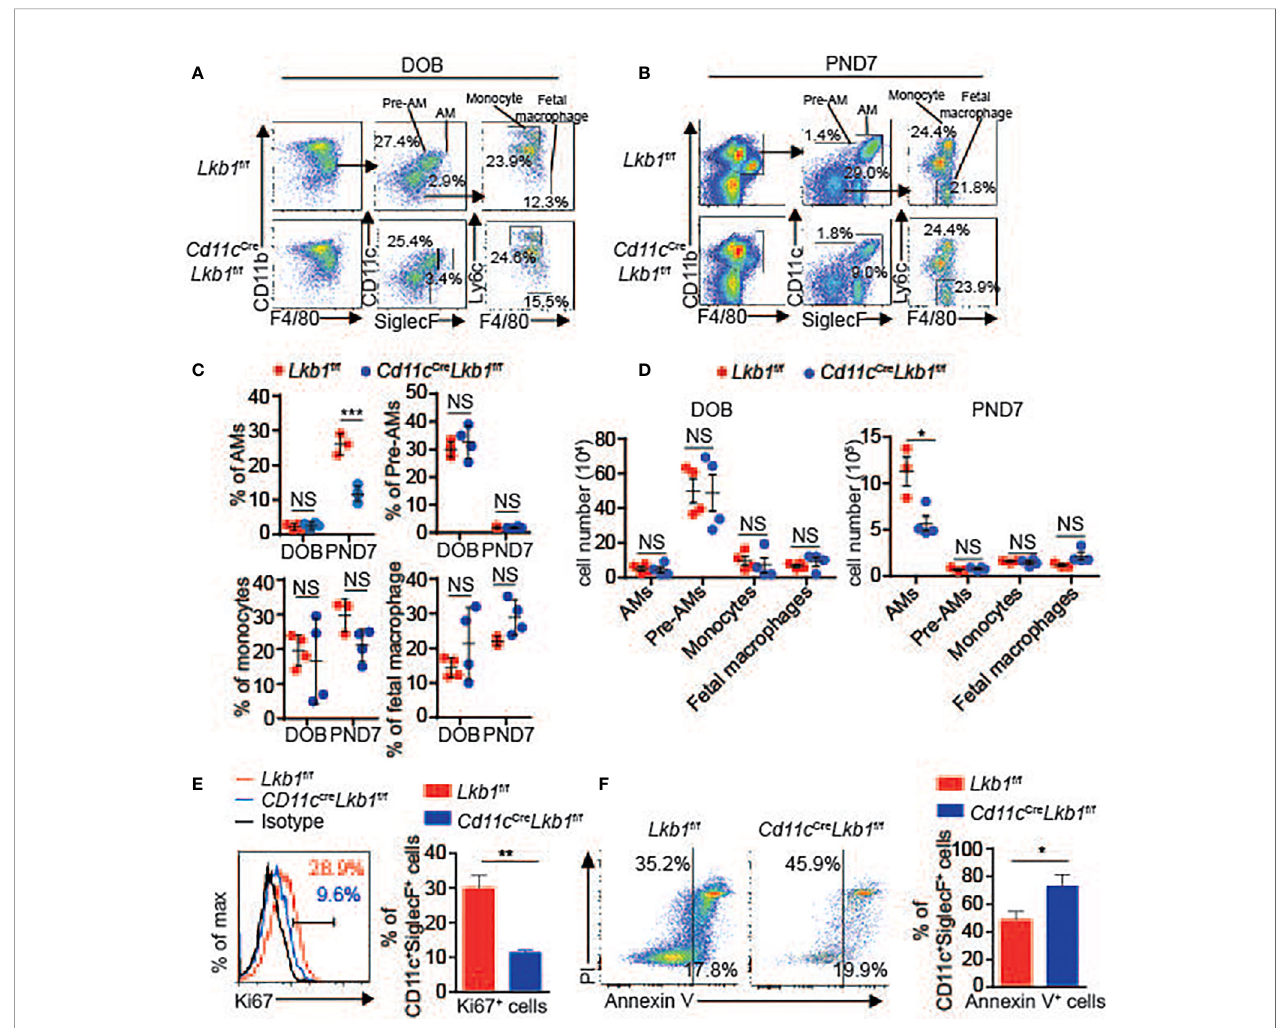
FIGURE 2 | Lkb1 deletion leads to increased apoptosis and impaired proliferation. (A, B) Representative fl ow chart showing the gating scheme to identify mature AMs (gated as CD11c + SiglecF + F4/80 + CD11b int ), pre-AMs (gated as CD11c + SiglecF − F4/80 + CD11b int ), monocytes (gated as CD11b high Ly6c + CD11c - SiglecF − F4/80 low ) and fetal macrophages (gated as CD11b + F4/80 + Ly6c − CD11c − SiglecF - ) in the lungs of Lkb1 f/f and Cd11c Cre Lkb1 f/f mice on DOB (A) and PND7 (B) . (C, D) The percentages (C) and absolute numbers (D) of mature AMs, pre-AMs, monocytes and fetal macrophages in the lungs of Lkb1 f/f and Cd11c Cre Lkb1 f/f mice on DOB and PND7 (n = 3 – 4). (E) Expression of Ki67 in AMs from Lkb1 f/f and Cd11c Cre Lkb1 f/f mice (n = 3). (F) Annexin V and PI staining of AMs and quanti fi cation of apoptotic AMs (assessed as Annexin V-positive cells) from Lkb1 f/f and Cd11c Cre Lkb1 f/f mice (n = 3). Each symbol (C, D) represents a mouse, and the results are presented as the mean ± S.D., NS (not signi fi cant) P > 0.05, * P < 0.05, ** P < 0.01, *** P < 0.001, (by Student ’ s t -test) (C , D , E , F) . All data represent at least three independent